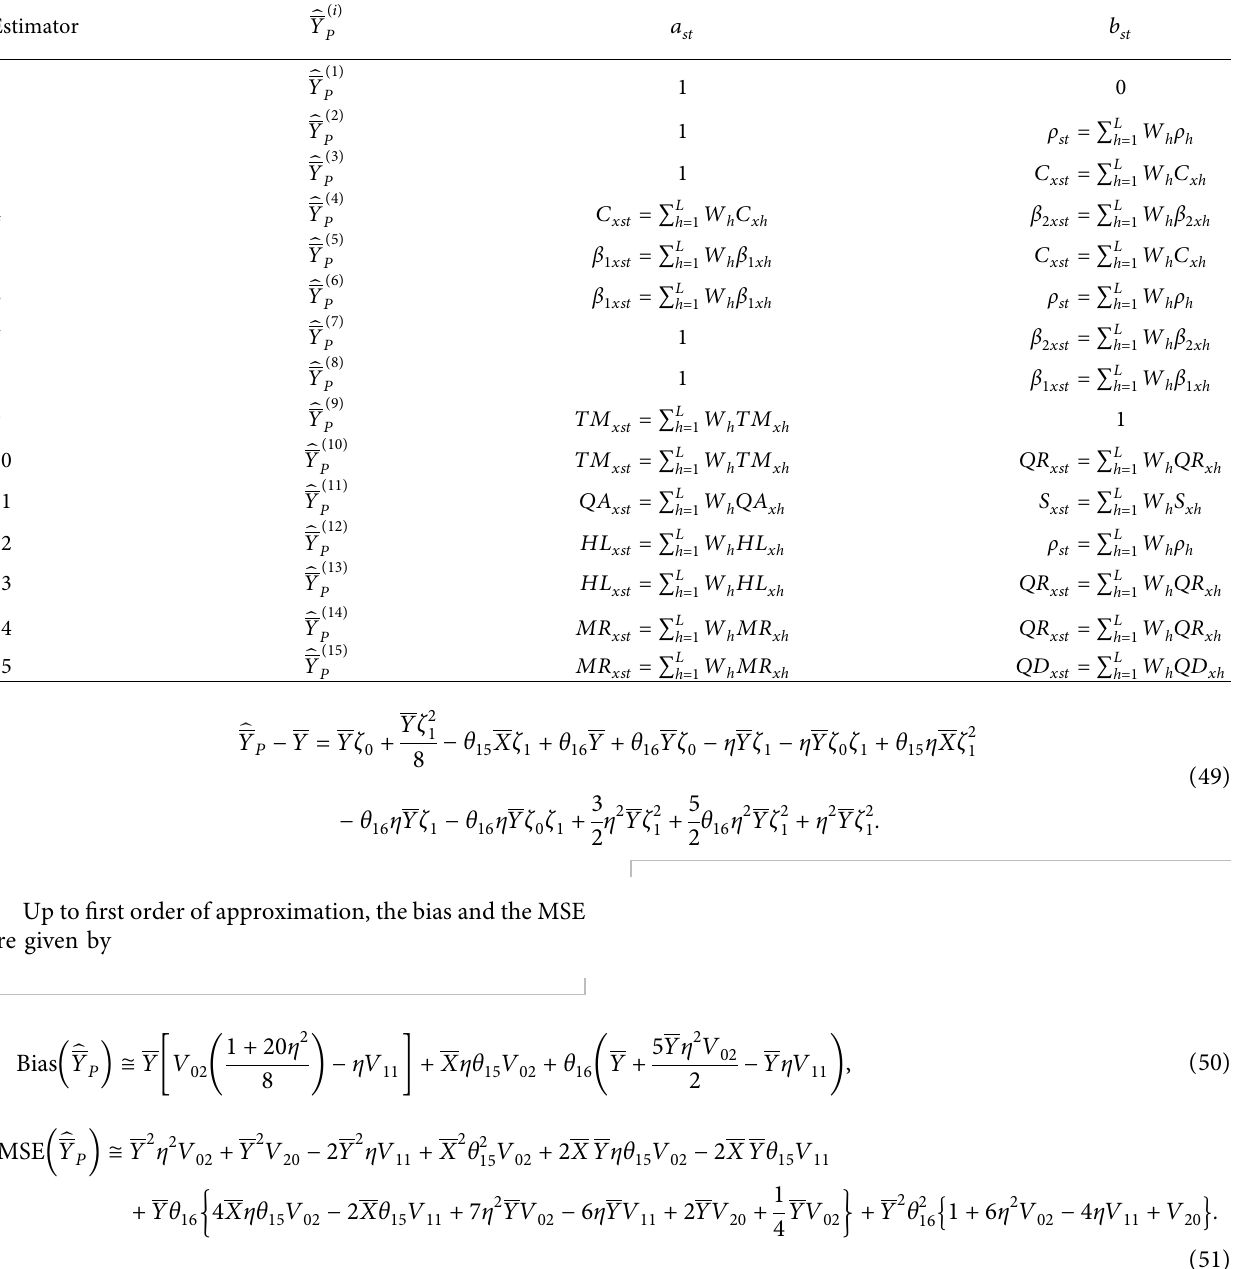
Table 1: Some members of the proposed